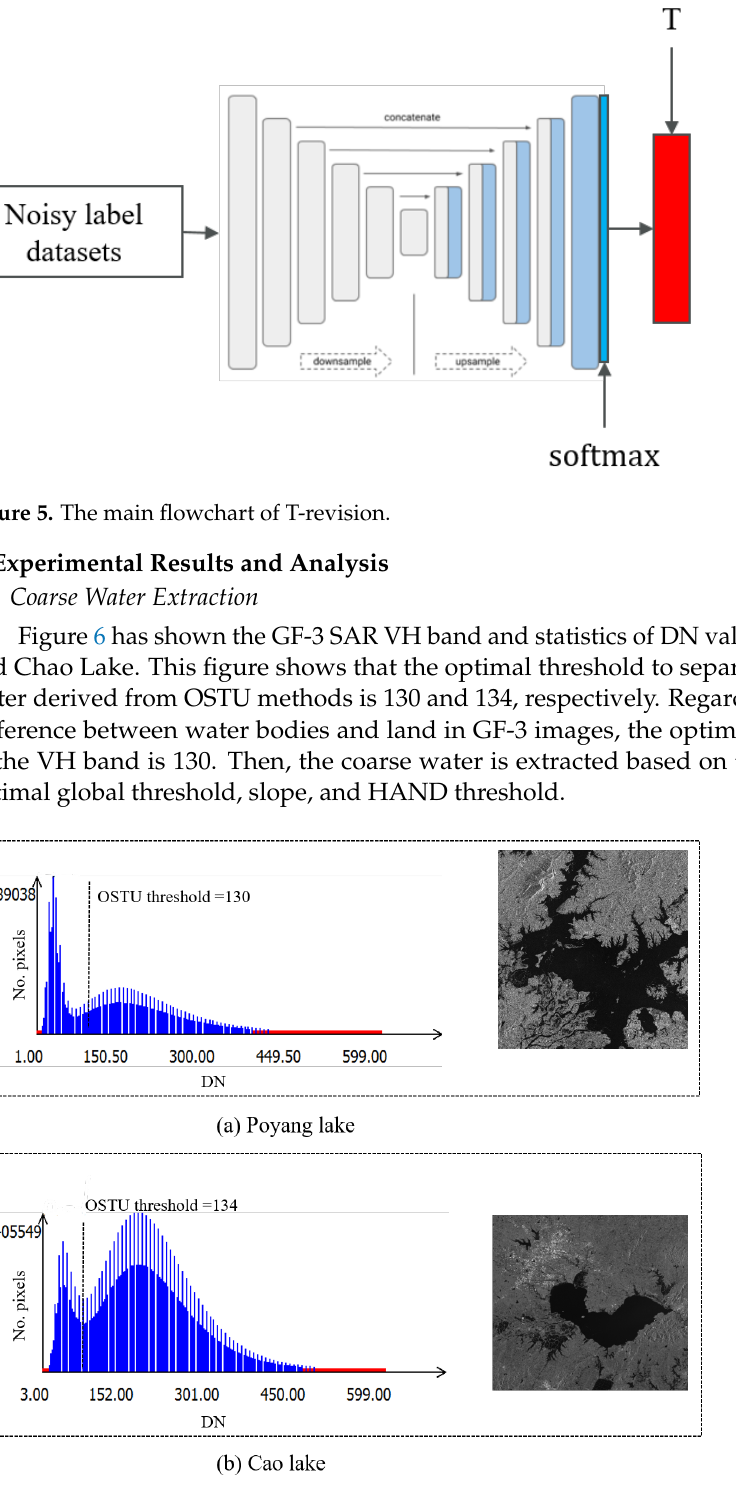
Figure 6. The GF-3 SAR HV band and statistics of DN values in Poyang Lake and Chao